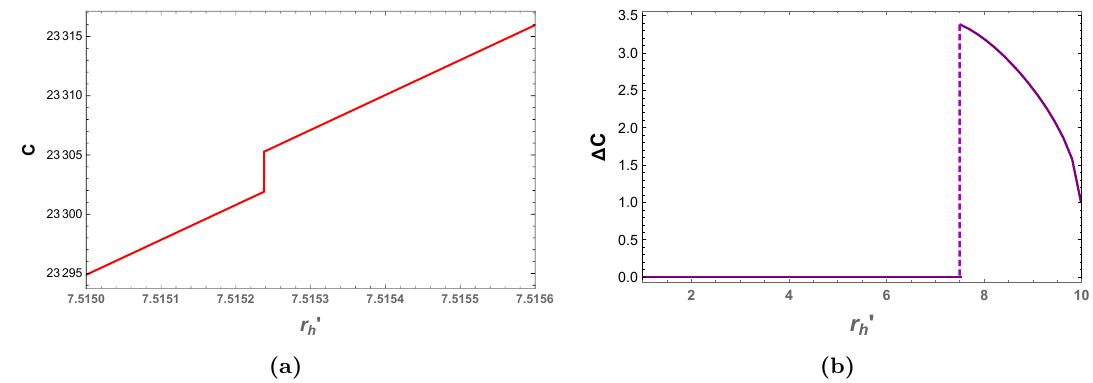
Figure 10. Variation of subregion complexity with respect to the throat horizon of radiation subsystem R 1 . Complexity shows a discontinuous jump at secret-sharing time. (b) Starting from the secret-sharing time the complexity of the partial island ∆ C decreases